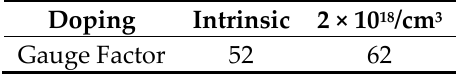
Table 2. Measured gauge